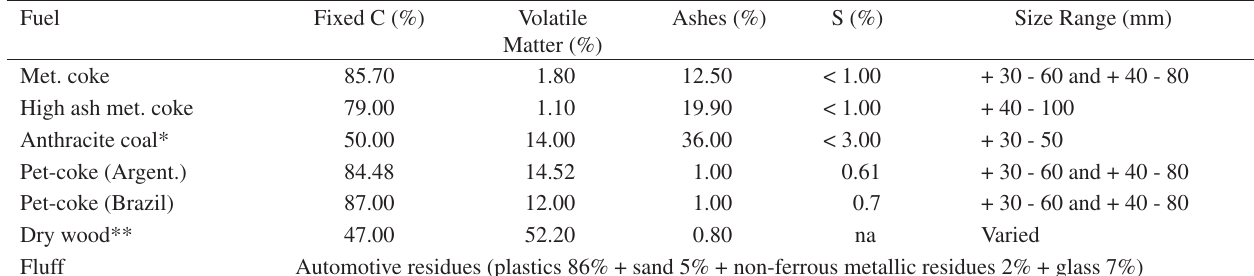
Table 1. Main types of solid fuels tested in pilot-plant.